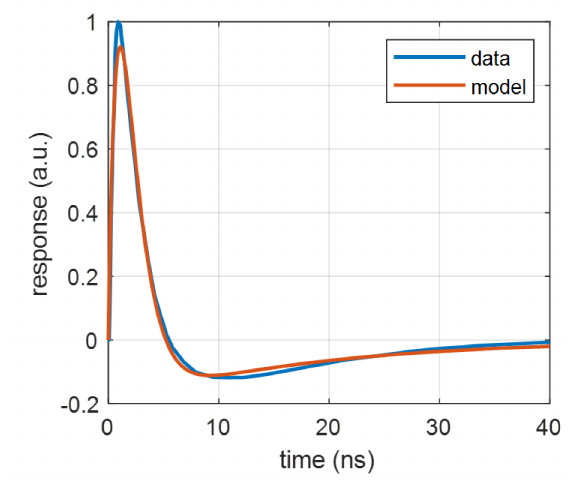
Figure 4. Fitting the function (5) to the measured capacitive-output waveform v p 2 for MICRORB- 10010: V 1 = 2.315, α = 5.860 × 10 7 s − 1 , β = 1.045 × 10 9 s − 1 , γ = 0.7067 × 10 9 s − 1